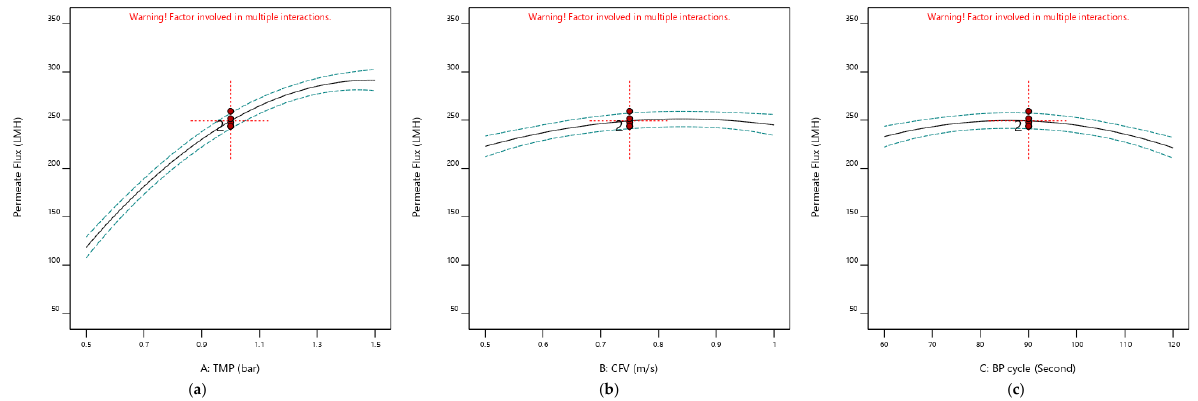
Figure 4. All independent factors (TMP, CFV, and Pulsatile cycle) perturbation for permeate flux considering one factor at time impact. (All design points are at 95% CI bands). ( a ) B: CFV = 0.75 m/s and C: BP cycle = 90 s. ( b ) A: TMP = 1 bar and C: BP cycle = 90 s. ( c ) A: TMP = 1 bar and B: CFV = 0.75 m/s.